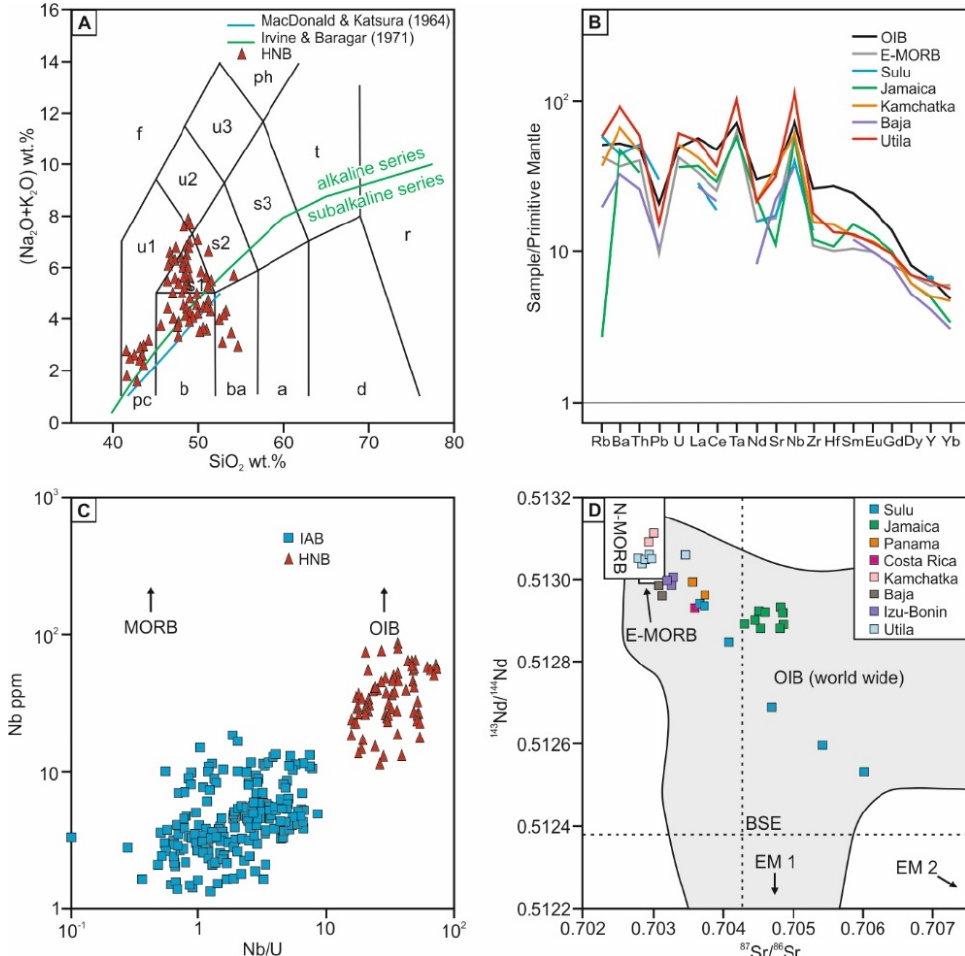
Figure 3. ( A ) Total alkalies-silica classification diagram [134] for high-Nb basalts [52,55,56,64,129–132,135–138]. Boundaries between the alkaline and the subalkaline volcanic series—MacDonald and Katsura (1964) and Irvine & Baragar (1971)—are, respectively, from [139,140]. Compositional fields: pc—picrobasalt, b—basalt, ba—basaltic andesite, a—andesite, d—dacite, r—rhyolite, s1—trachybasalt, s2—basaltic trachyandesite, s3—trachyandesite, t—trachyte, u1—basanite or tephrite, u2—phonotephrite, u3—tephriphonolite, ph—phonolite, f—foidite [134]. ( B ) Trace element compositions of high-Nb basalts from Honduras [131], Kamchatka [52] and Sulu arc [130] compared to low-degree enriched mid-ocean ridge basalt (E-MORB) melt [141] and average ocean island basalt (OIB) [142]. ( C ) Nb versus Nb/U diagram for basaltic rocks from volcanic arcs modified after [58]; data sources: high-Nb basalts (HNB) [52,55,56,64,129–132,135–138], arc basalts [52,136,143–150]. ( D ) Sr and Nd isotopes in high-Nb basalts from Sulu arc [130], Jamaica [129], Panama and Costa Rica [56], Kamchatka [52], Baja California [55], Izu-Bonin [132] and Utila, northern Honduras [131]. Average composition of low-degree E-MORB melt is from [141]. Fields of worldwide OIB and normal mid-ocean ridge basalts (N-MORB) are from [52,151], respectively.